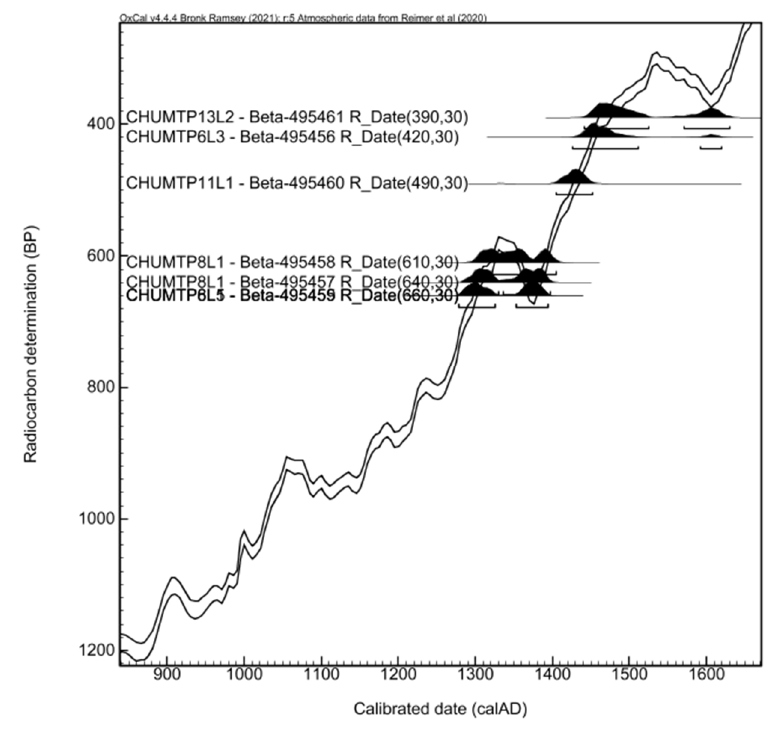
Figure 10. Calibrated 14 C dates of charcoal recovered from Chumnungwa.